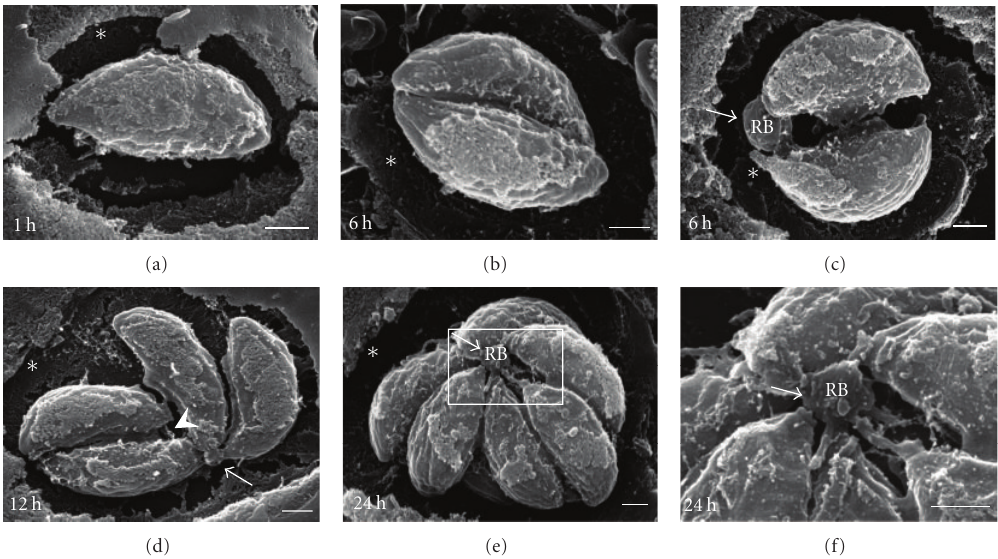
Figure 6: The intravacuolar MNN plays a structural role in keeping parasites tightly organized as “rosettes” during endodiogeny. (a–f) SEM- Tanaka micrographs of MDCK cells, infected by Δ GRA2 mutant for 1, 6, 12, and 24h, show loss of the MNN and alteration of interparasite cohesion within the PV. Arrows in (c–f) indicate residual amorphous and fibrous material at the parasites posterior end instead of the typical RB. Arrowheads in (d) show membranous fibers linking parasites together and to the PVM. Asterisks in (a–f) indicate an apparent empty space at the PV’s periphery. Bar = 1 µ m.